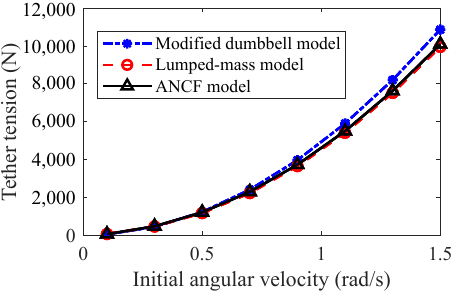
Figure 18. Impact force on the satellite with respect to the initial angular velocity.